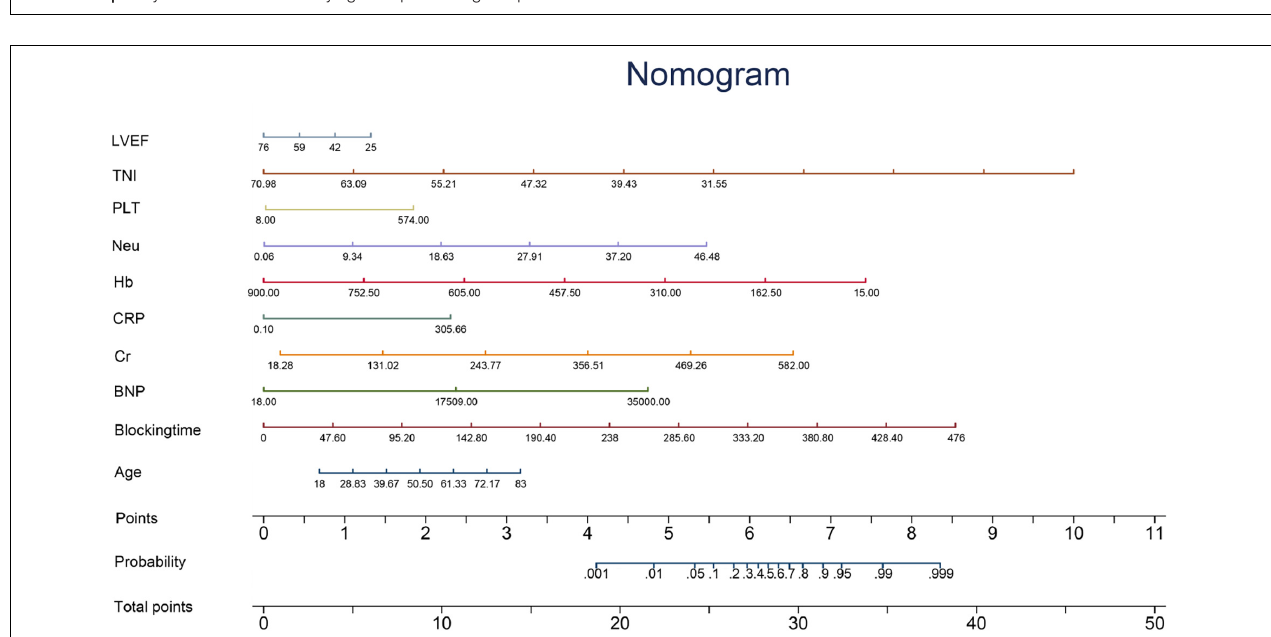
FIGURE 1 | Analysis overview for identifying best-performing risk prediction model.